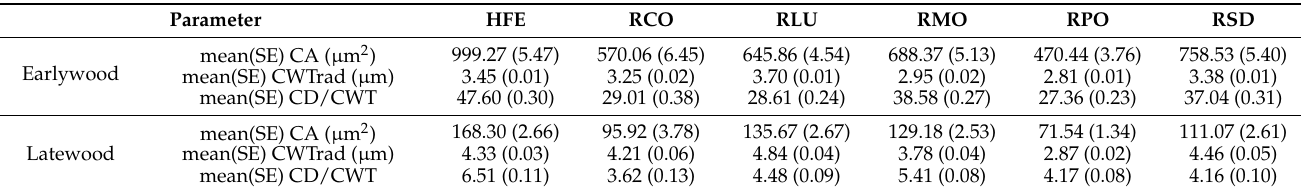
Table 3. Mean and standard error (SE) of the wood anatomical features of earlywood and latewood for each studied site. CA: cell area; CWTrad: radial cell wall thickness; CD/CWT: ratio of the cell diameter and radial cell wall thickness. Site abbreviations: Suhardul Mic (RCO), Tinovul Luci (RLU), B ă ile Tusnad (RMO), Poiana Stampei (RPO), Saru Dornei (RSD), Feny˝of˝o